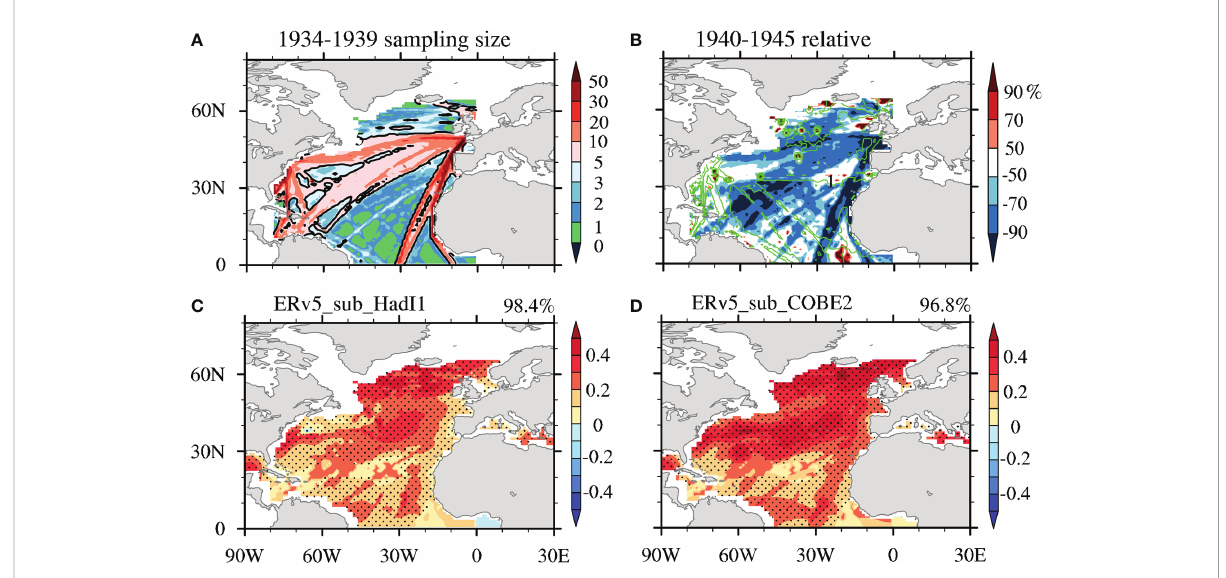
FIGURE 4 (A) The SST sampling size (unit:/month) during 1934 – 1939 and (B) the percentage change in the sampling size during 1940 – 1945 relative to that during 1934 – 1939. The green contour is the >1/month sampling size during 1940 – 1945. (C, D) The AMO patterns derived from merged SST data based on LFCA. The merged SST data are constructed by replacing ERv5 SST data with (C) HadI1 or (D) COBE2 SST data over the total region of sharply decreased sampling size [>50% in the colored region in (B) ] during 1934 – 1950. The AMO CIs are shown in the top right. The unit for (C, D) is